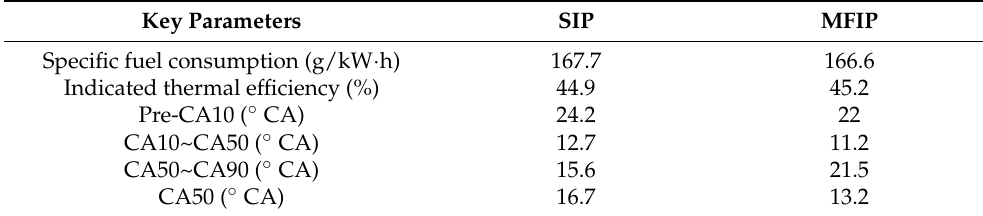
Figure 6. The comparison of the SIP and MFIP in heat release rate (bule lines) and accumulated heat release (orange lines). Table 6. The characteristic combustion parameters of SIP and